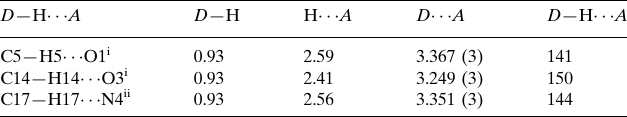
Hydrogen-bond geometry (A˚ , (cid:1)